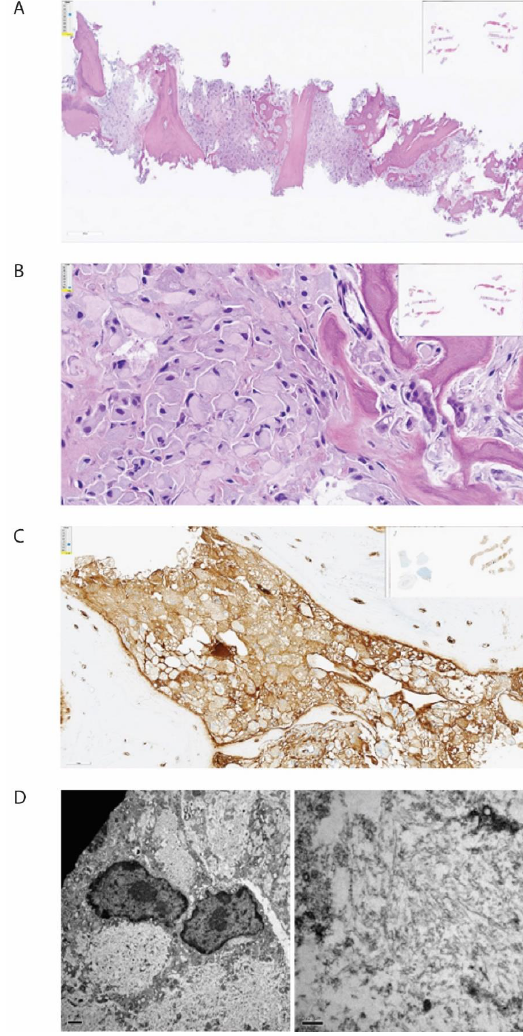
Figure 2. Histopathological examination of biopsy from corpus vertebrae. The figure demonstrates the biopsy from the patient’s corpus vertebrae L1. ( A ) Hematoxylin-eosin stain in low magnification demonstrating bone repair and bone marrow with the absence of organized hematopoiesis and maximal infiltration by histiocytes. ( B ) Hematoxylin-eosin stain in higher magnification demon- strating histiocytes with intracellular amorphous material. ( C ) Immunohistochemical staining for kappa light chain, demonstrating positivity in the histiocytes (brown color). ( D ) Electron microscopy, low magnification, showing bright intracellular material ( left ) and high magnification, showing no fibrils but spread tiny tubules ( right